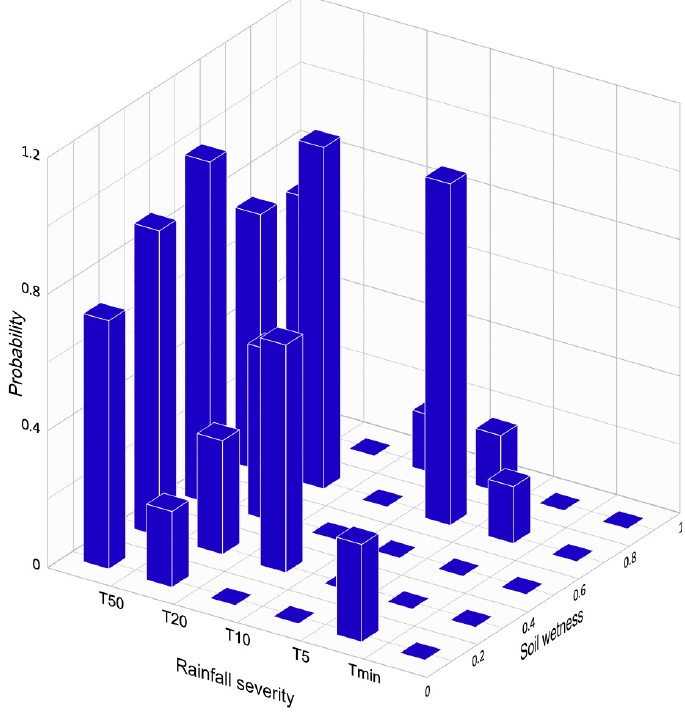
Figure 6. Histogram of conditional probability of occurrence of landslides based on rainfall severity and antecedent soil moisture.